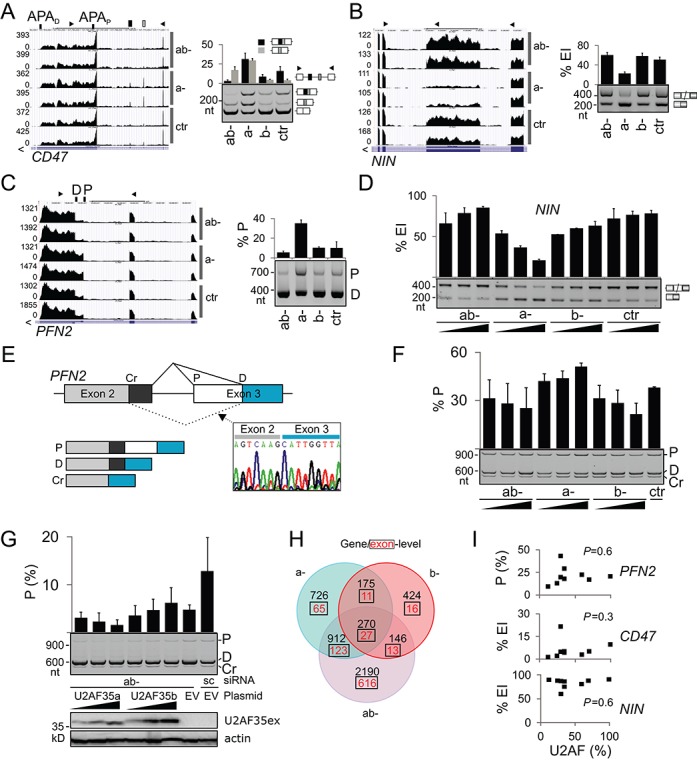
Evidence for distinct function of alternatively spliced U2AF35 isoforms. (A-C) Genome browser views of endogenous transcripts showing isoform-specific responses to U2AF35 depletion (left panels) and their validation using RT-PCR (right panels). (D) NIN exon inclusion levels in the indicated depletions. Final concentration of siRNAs was 6.7, 20 and 60 nM. Error bars are SDs. (E) Schematics of the PFN2 minigene. Chromatogram illustrates transcripts spliced to the cryptic 5′ss of intron 2 (Cr); P, D, proximal and distal 3′ss. (F) Opposite effects of U2AF35a and U2AF35b on splice-site selection in exogenous PFN2 transcripts. Spliced products are shown in panel E. (G) Isoform-specific rescue of 3′ss of PFN2 intron 2. The amount of rescue plasmid DNA was 20, 65 and 200 ng. Immunoblot with Xpress (U2AF35ex) and β-actin antibodies is shown in the lower panel. (H) Three-way Venn diagram showing overlaps of differentially expressed genes/exons (q < 0.05) in ab-, a- and b- depletions versus controls. Gene lists are in Supplementary Tables S2 and S3. (I) Exon/proximal 3′ss usage in the indicated transcripts (y axis) and residual U2AF heterodimer levels (x axis) estimated from a transfection experiment shown in Supplementary Figure S3.